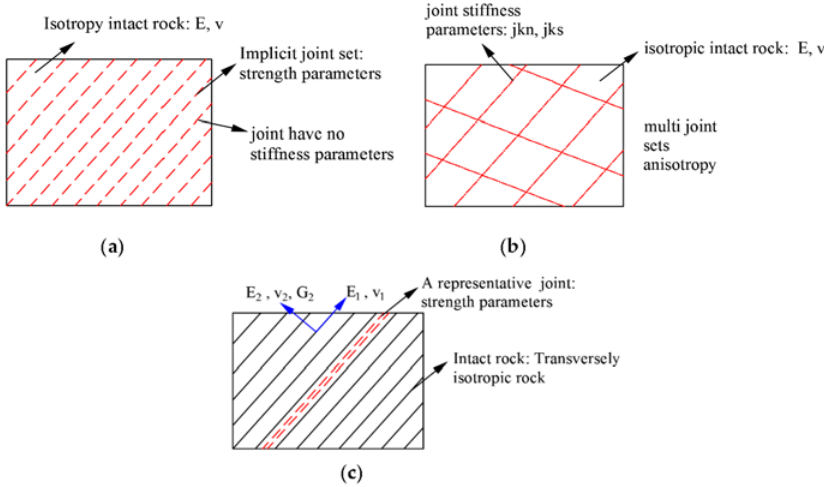
Figure 1. Schematic for isotropic and anisotropic models: ( a ) ubiquitous joint model, ( b ) multi joint model, ( c ) anisotropic model with transversely isotropic rock matrix and representative joint orientation.